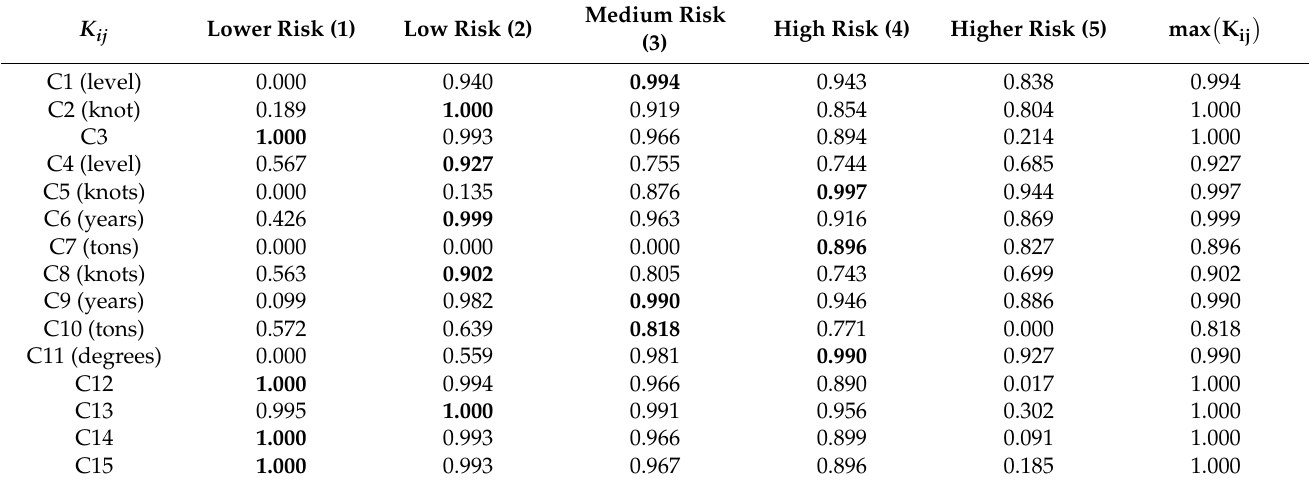
Table 8. Relevance of indicator data of “Hua Jinzhou” to each level of the cloud model. (The bold value in the table represents the final risk level of the indicator).